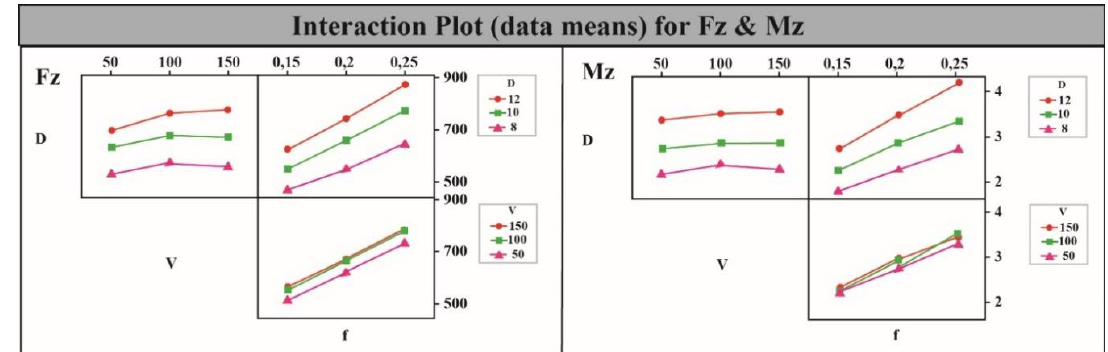
Figure 6. Interaction plot for F z and M z .